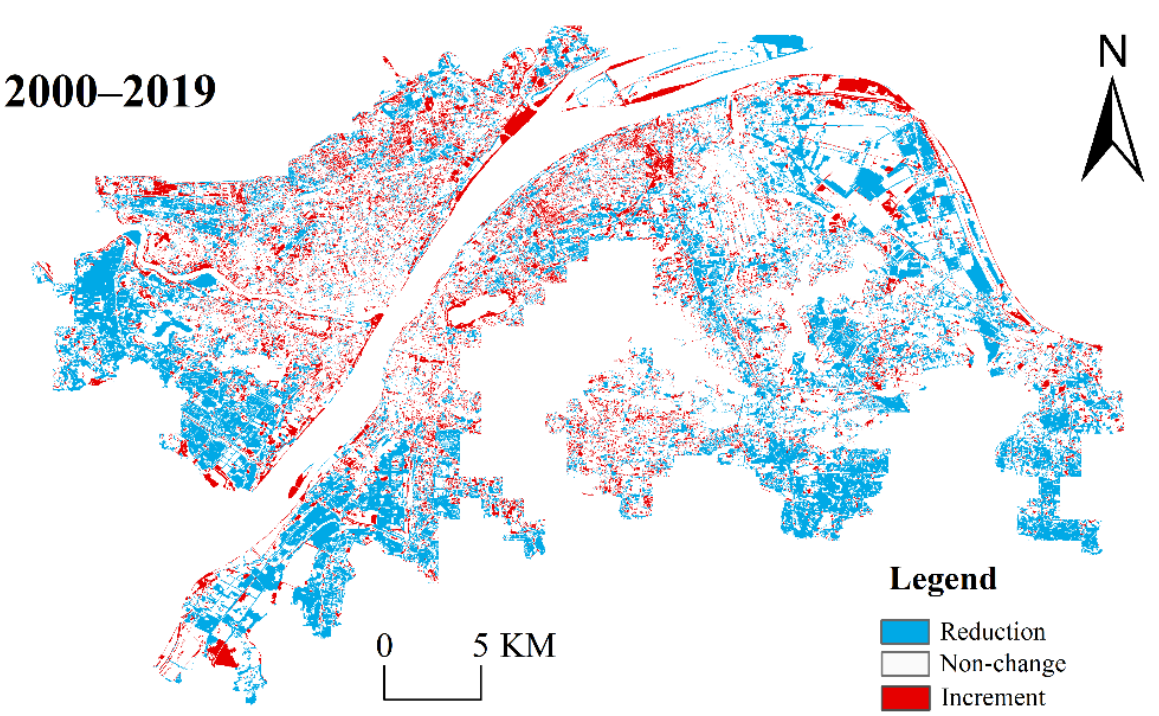
Figure 2. Spatial change in green space from 2000 to 2019 in the central city of Wuhan (reduction in blue represents the green space occupied by other types of land use; increment is the area transferred from other land use types to green space).